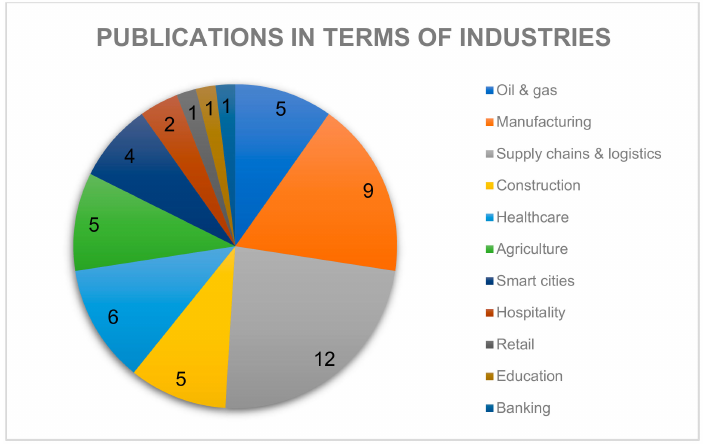
Figure 2. Distribution of articles published from 2015 to July 2021.